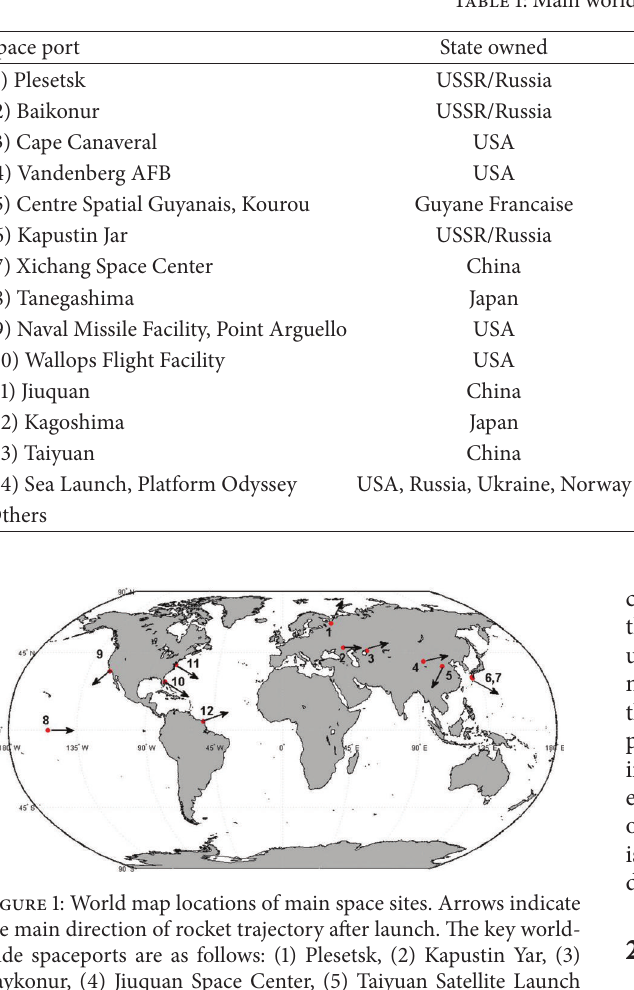
Table 1: Main world space ports.